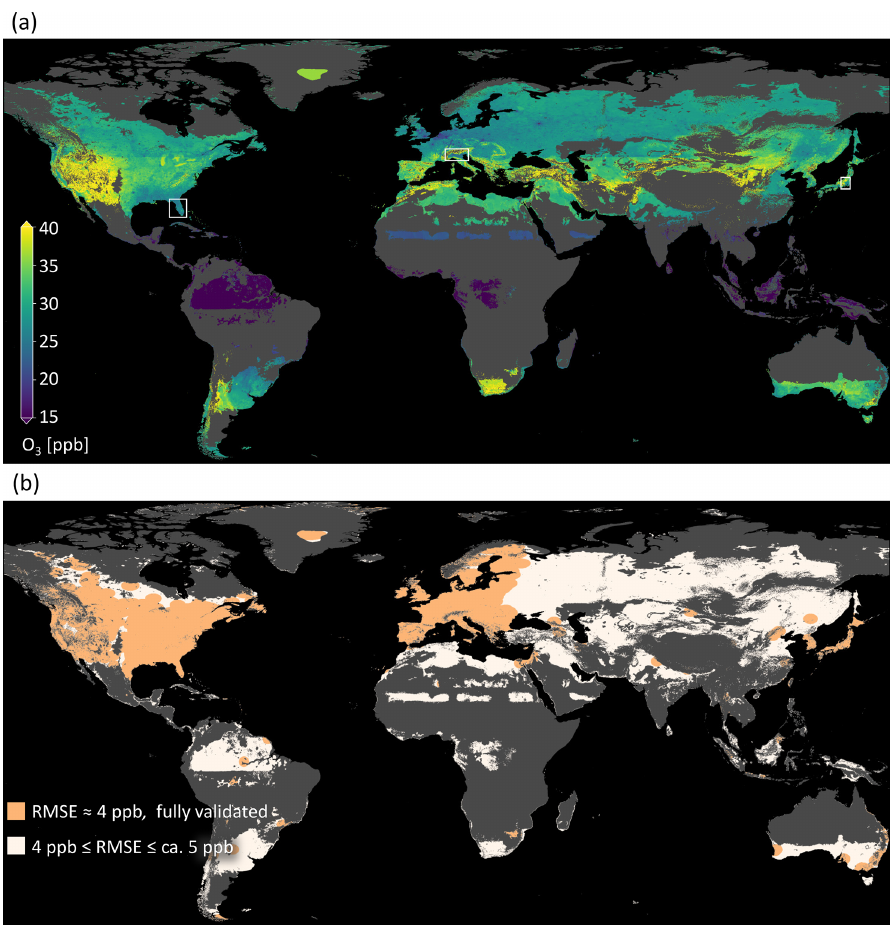
Figure 9. The final ozone map as produced in this study. Panel (a) shows the ozone values; (b) shows the uncertainty estimates. The areas shown in Fig. 10 are highlighted by white boxes.